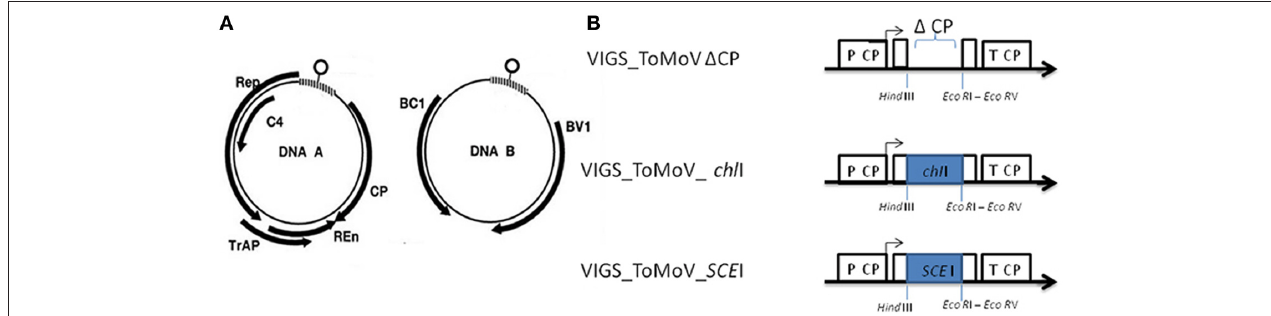
FIGURE 1 | ToMoV silencing vector. (A) Diagram of the five genes of ToMoV component A: replication-associated protein ( Rep ), transcription activator protein ( Trap ), replication enhancer ( Ren ), coat protein ( CP ), and the two genes of ToMoV component B: movement proteins ( BC 1 and BV 1) (Figure 1A modified from Gutierrez, 2002). (B) Organization of the modified ToMoV vector used in VIGS of ChI I and SCE I genes. The capsid’s promoter is shown as P CP. The capsid protein gene ( CP ) was deleted by reverse PCR to generate 1 CP , and portions of ChI I and SCE I were cloned into this region with EcoR I and Hind